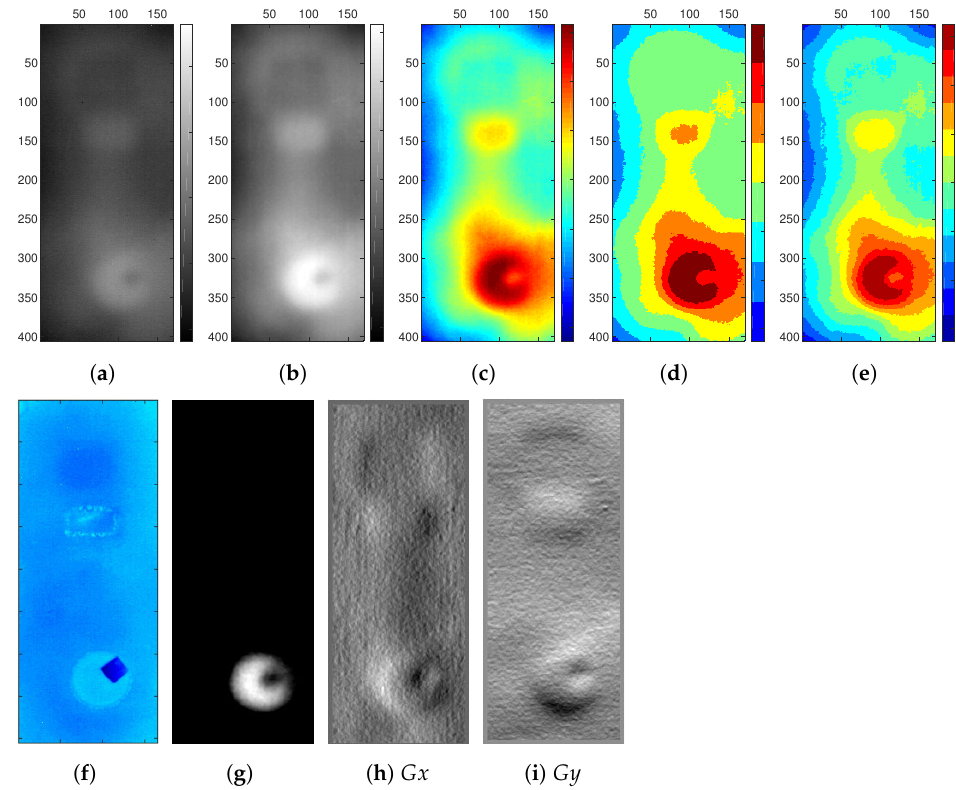
Figure 10. LPT analysis; experiment 2. ( a ) An example of the raw image. ( b – e ) After pre- and post- processing. ( f ) A sample thermogram for experiment 2 without any specimen for cavity configuration 3. ( g ) Thresholding. ( h , i ) Gradient of the image along the x and y direction: Gx = ∂ I Gy = ∂ I ( x , y ) ∂ y